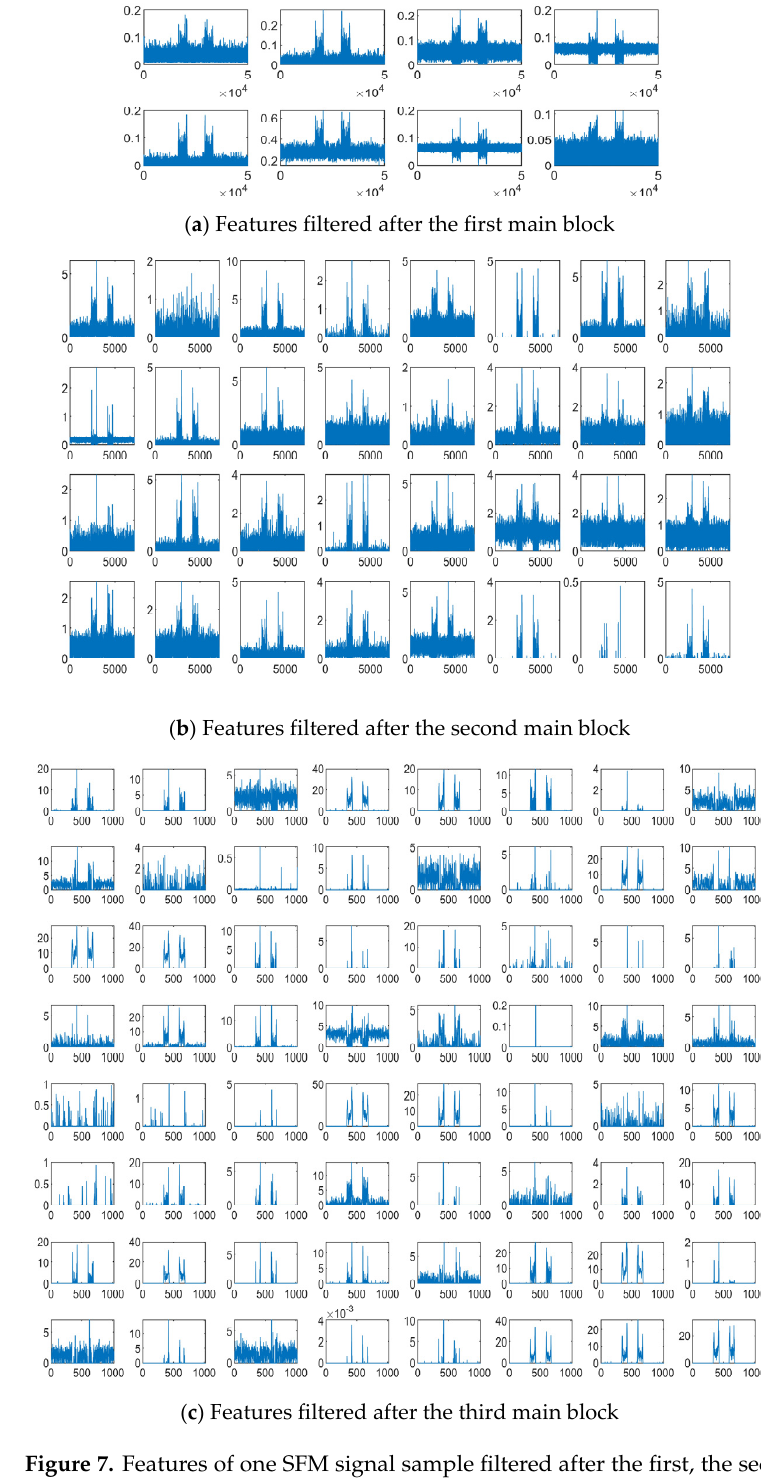
Figure 7. Features of one SFM signal sample filtered after the first, the second and the third main block when the SNR is − 10